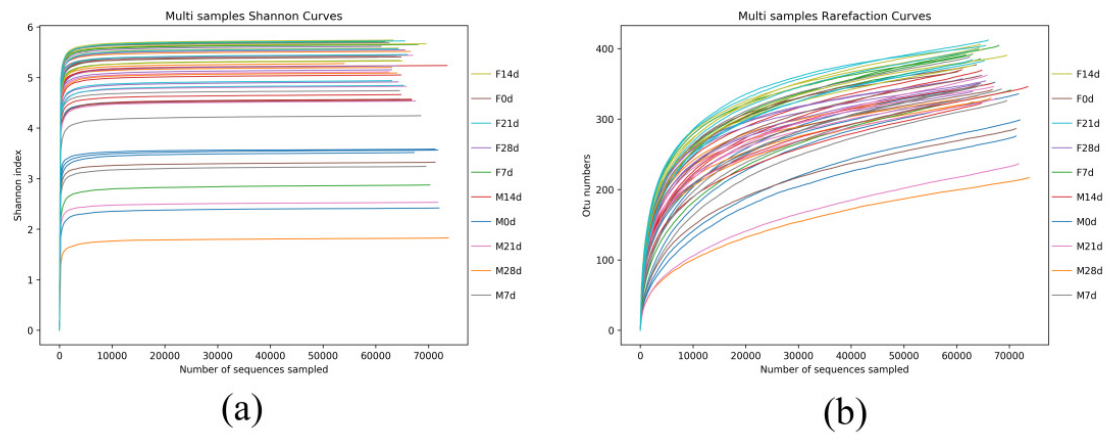
Figure 1. All samples Shannon index curve and Rarefaction curve. ( a ): Shannon curves of the multi samples; ( b ): Rarefaction curve of the multi samples.